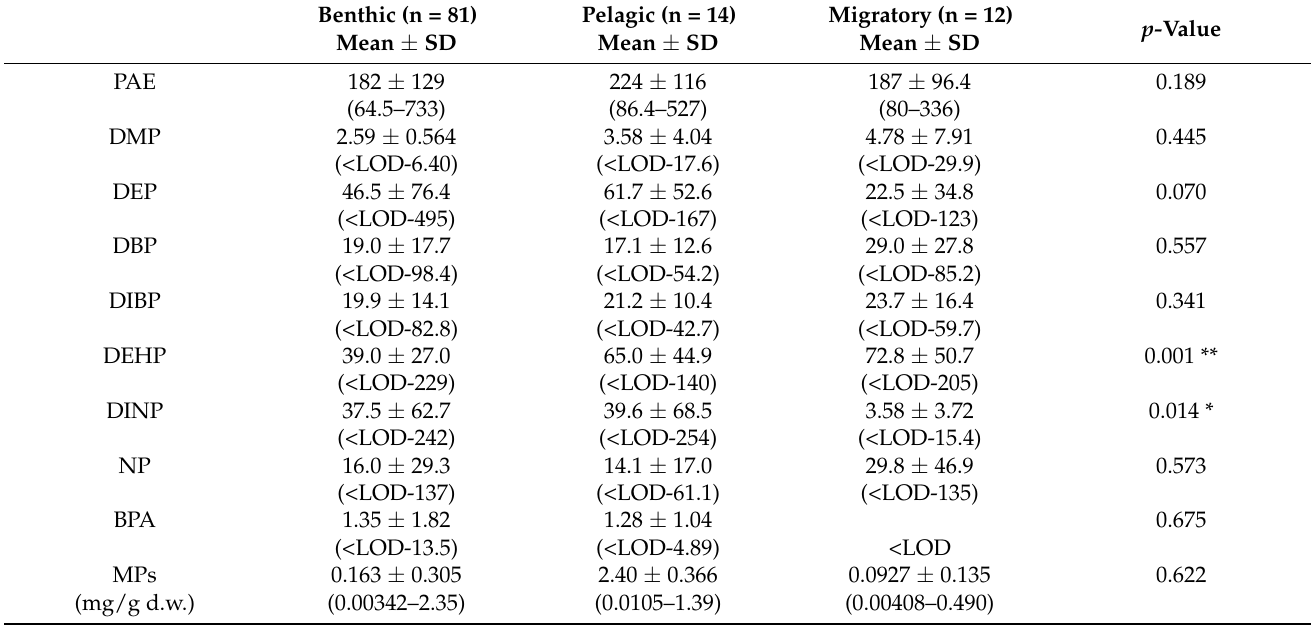
Table 2. Levels of PAEs, NP, BPA, and MPs in the estuarine fish based on the fish habitat or ecological niche (ng/g d.w.). Benthic (n =